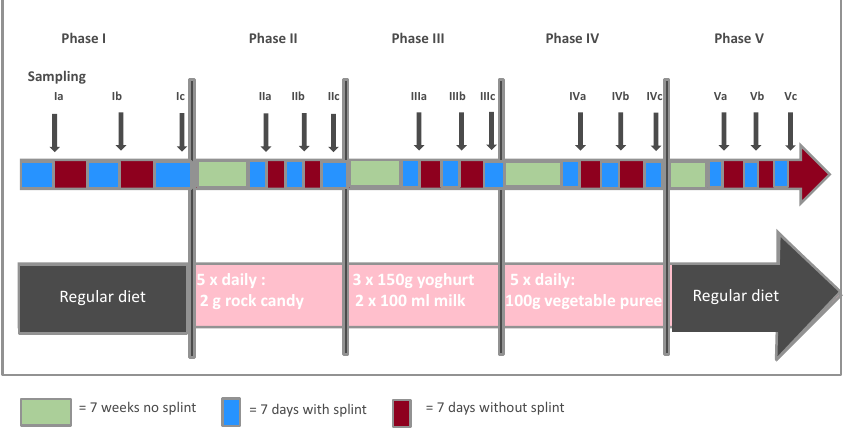
Figure 1. Description of the study design.